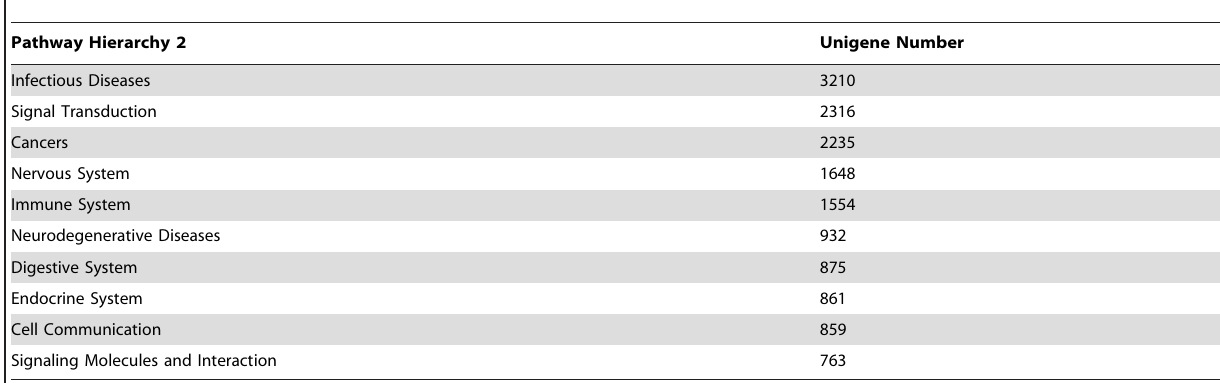
Table 3. Top 10 list of the gene number of Pathway Hierarchy